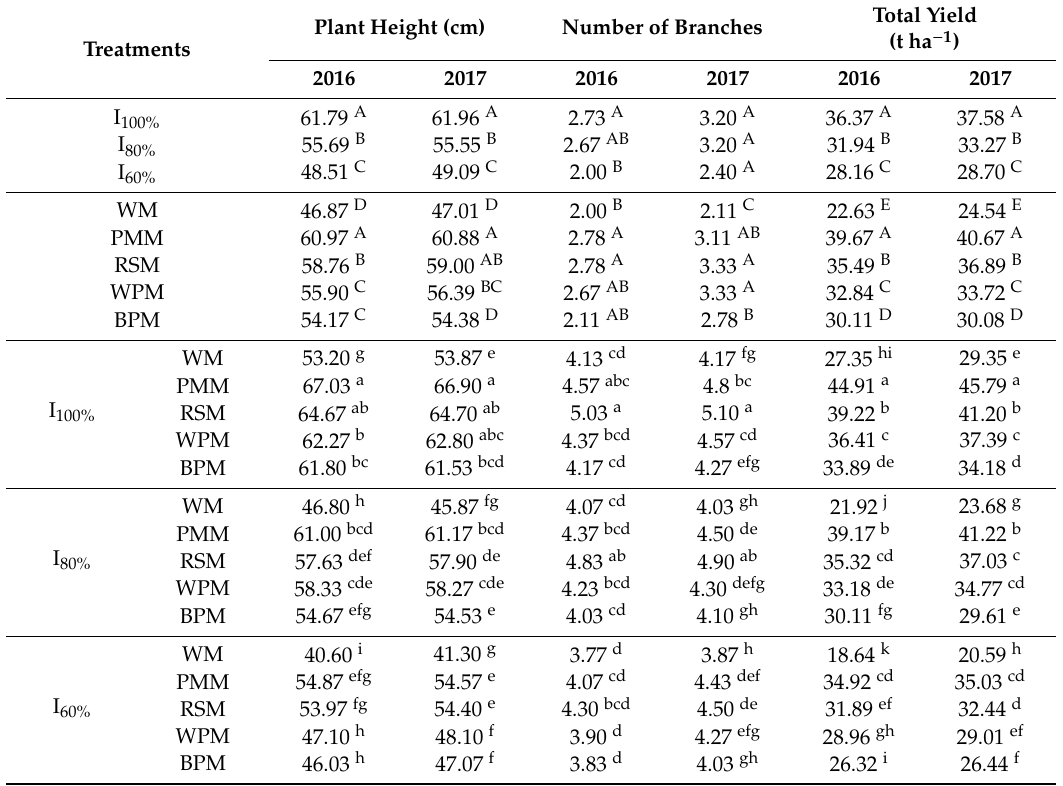
Table 6. E ff ect of irrigation and mulching treatments and their interaction on the plant height, number of branches, and total yield during 2016 and 2017.